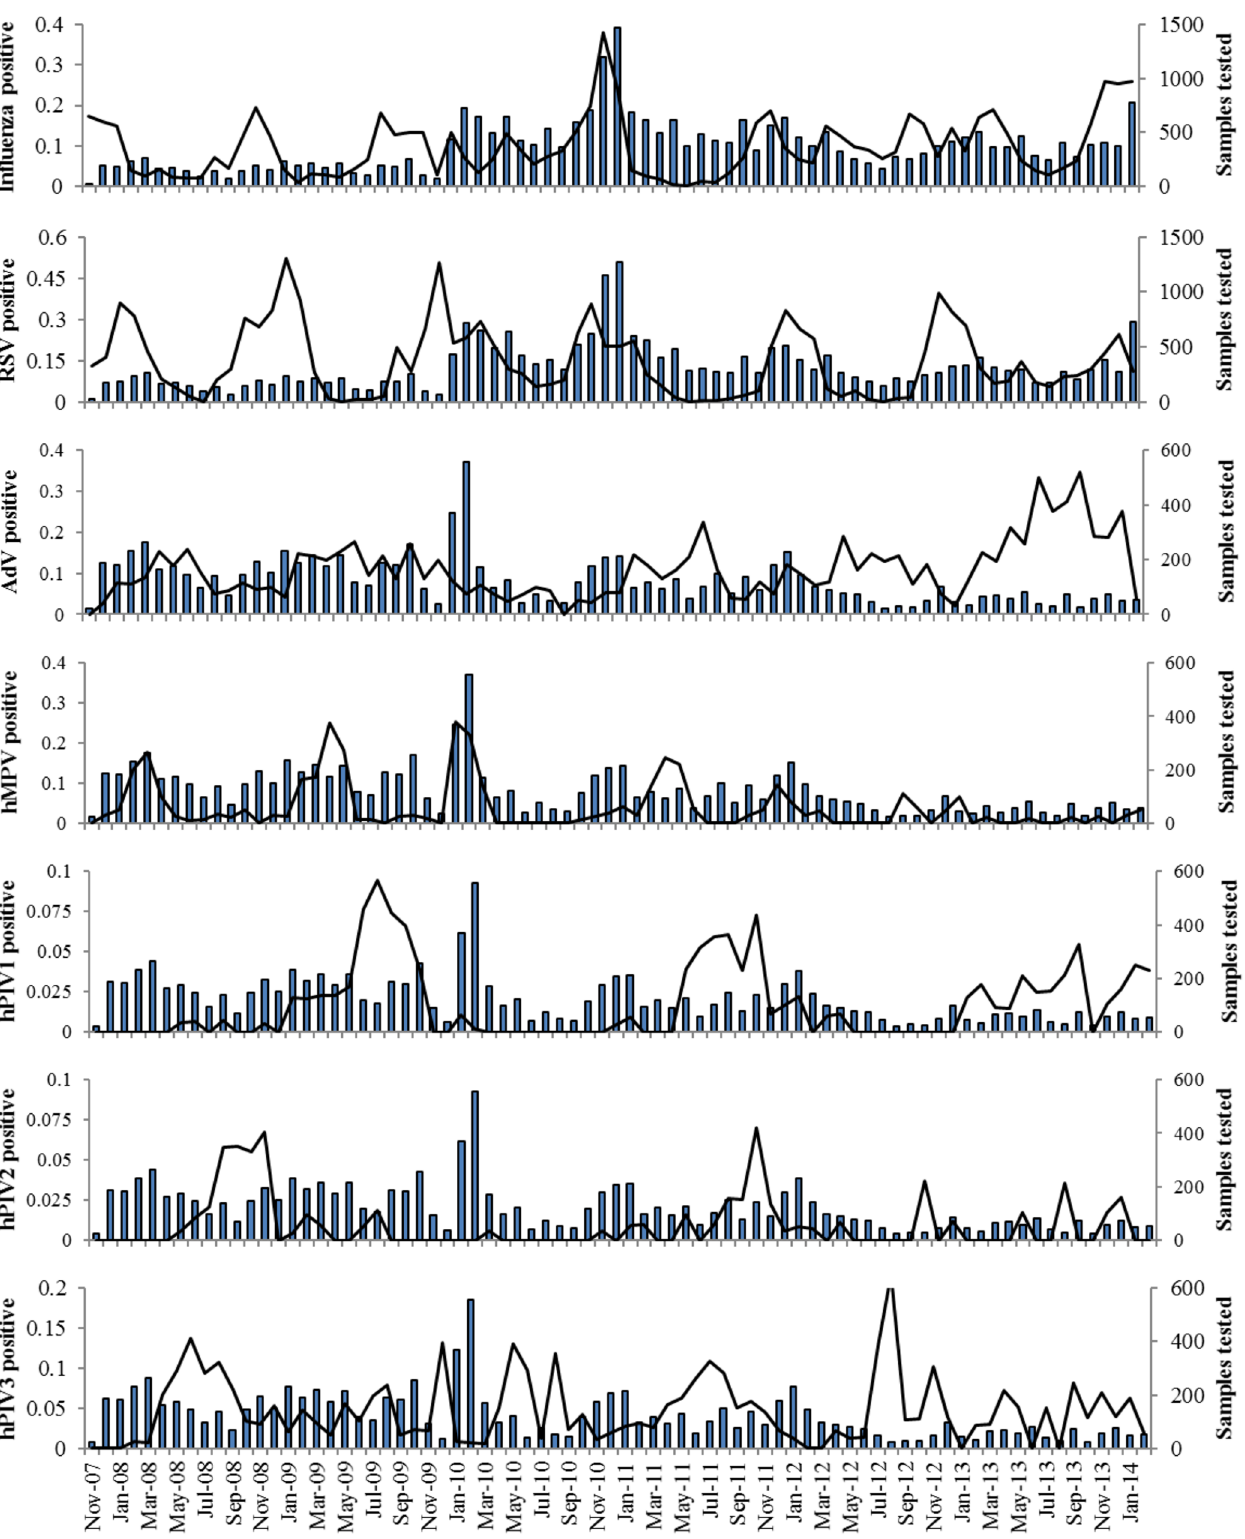
Fig 1. Seasonality of viral respiratory pathogens Bars indicates the total number of samples tested for each pathogen (shown on right vertical axis). Lines indicate the proportionof positive samples for each pathogen (shown on left vertical axis). Vertical axes vary between pathogens.Horizontal axes indicatetime in monthly intervals from November 2007 through February